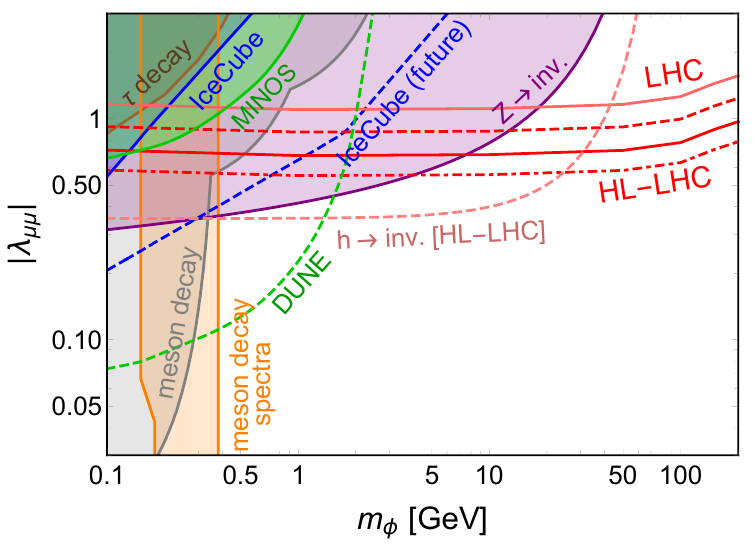
Figure 10 . The same as in (cid:12)gure 8, but for the coupling j (cid:21) (cid:22)(cid:22) j . Here we also show the limit on j (cid:21) (cid:22)(cid:22) j from MINOS (green) and prospect at DUNE (dashed green).